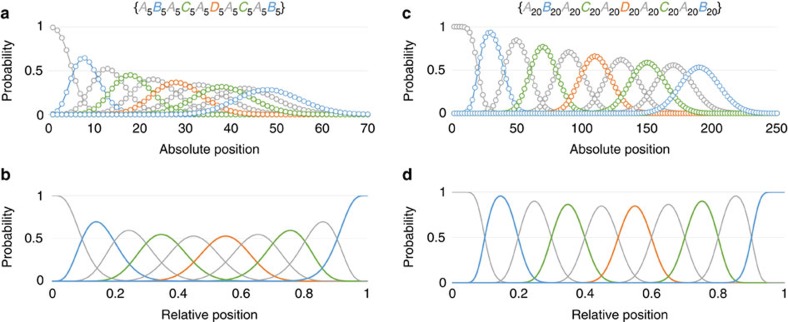
Monomer distributions.Probability of finding monomers from each block of an {A5B5A5C5A5D5A5C5A5B5} (a,b) or {A20B20A20C20A20D20A20C20A20B20} (c,d) decablock copolymer as a function of absolute position (a,c) and relative position (b,d) along the polymer chain.